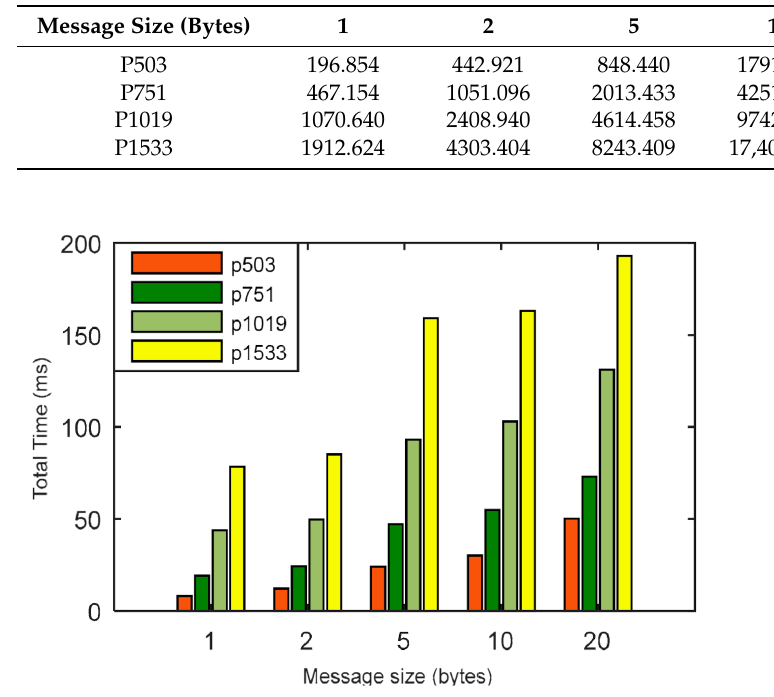
Figure 7. Total time to perform the operations considering different message sizes (in bytes) for various p